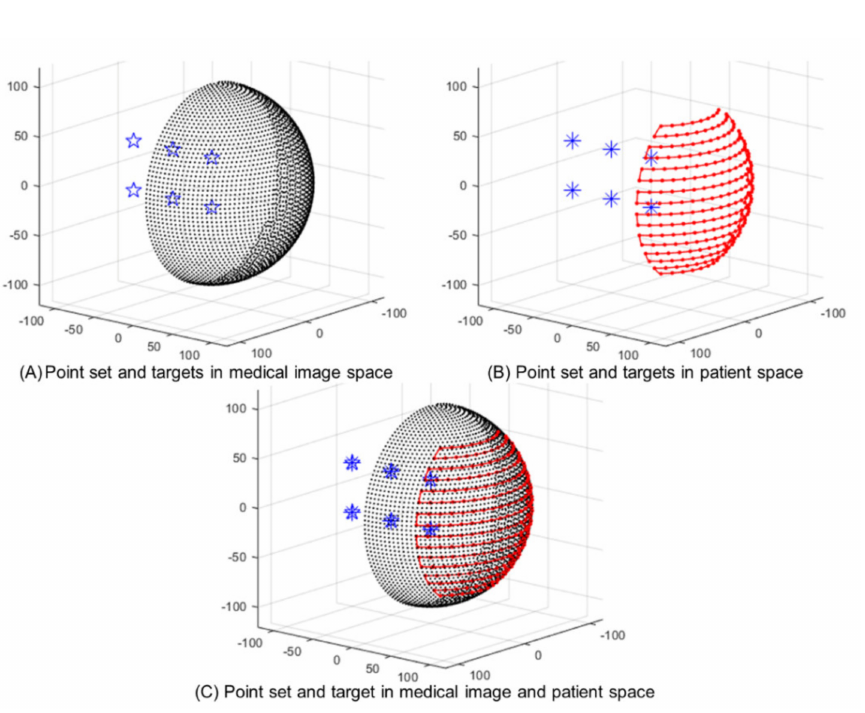
Figure 3. Hemisphere model ( A – C